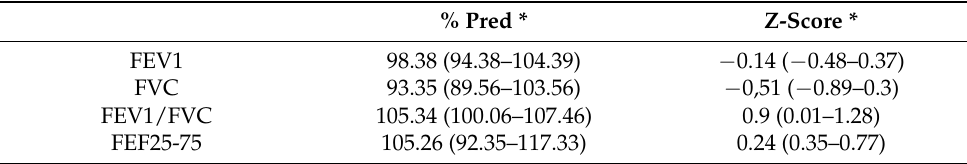
Table 2. Spirometry values (expressed as percent of predicted values and as Z-score) of the re- cruited